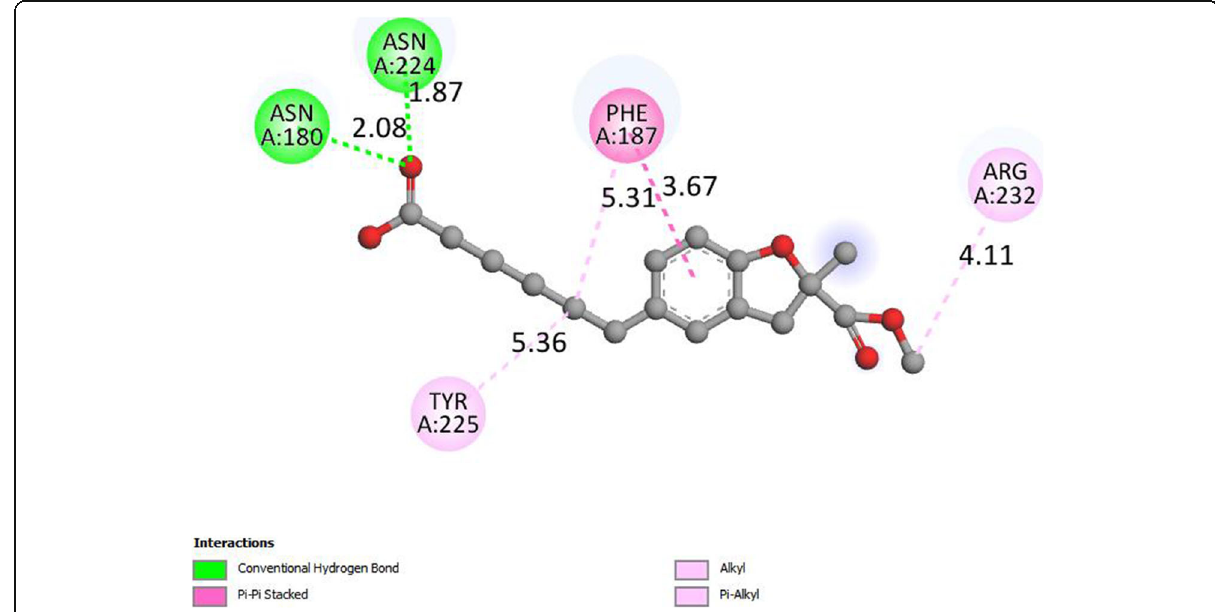
Fig. 6 Interactions of DHB2+3dra